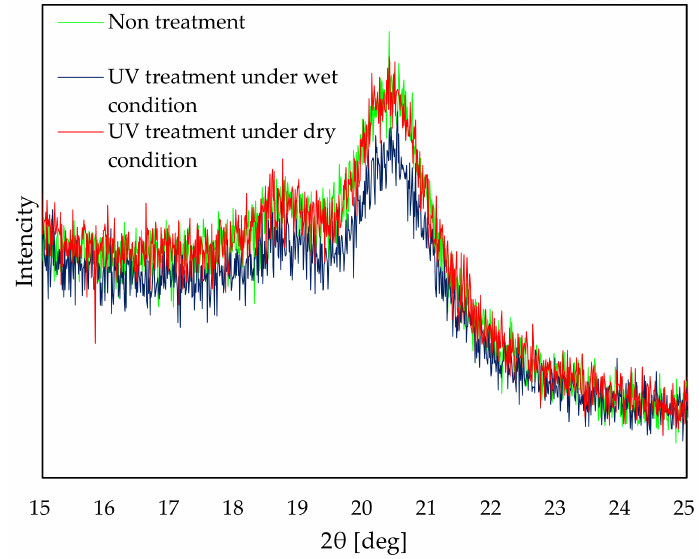
Figure 6. Diffraction pattern of each test piece obtained by the GIXRD method. (A504X90B) wet conditions: 6.6 g/m 3 and dry conditions: 2.6 g/m 3